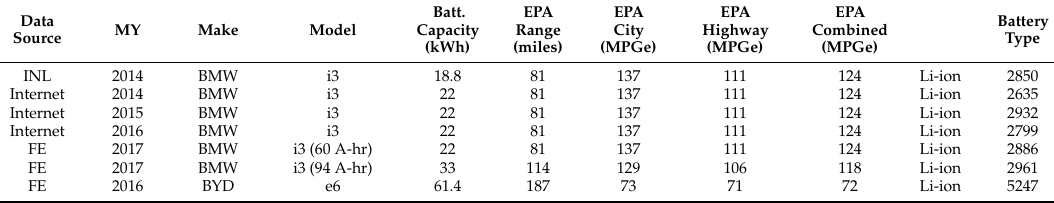
Table A1. Vehicle data for fuel economy and driving range analysis (Figures